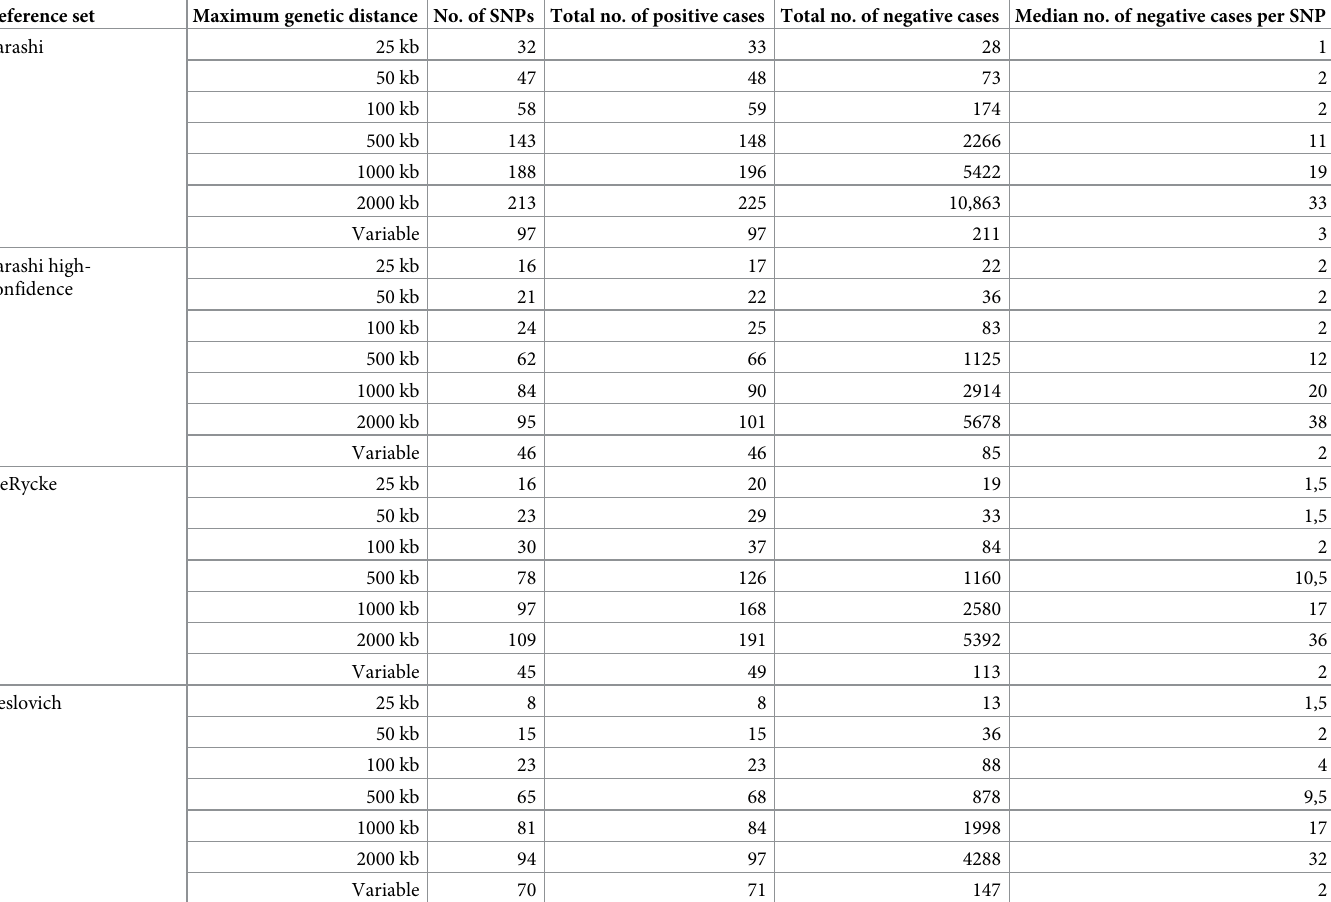
Table 1. Number of positive and negative cases in the reference sets for different genetic intervals. Maximum genetic distance indicates the maximum allowed dis- tance between a SNP and a gene. A variable maximum distance is based on the linkage disequilibrium as determined by DEPICT. Number of SNPs is the number of SNPs for which at least 1 positive case was found within the genetic